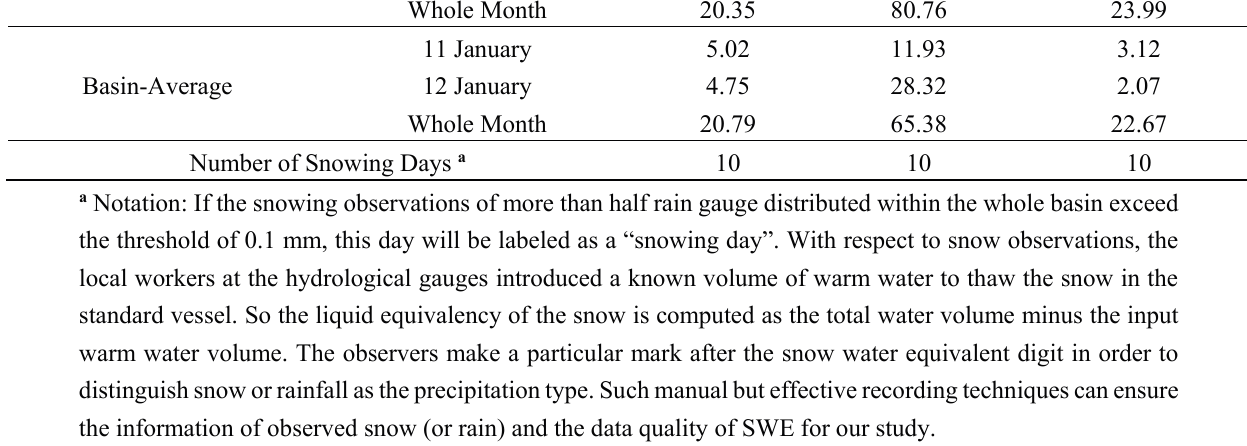
Table 4. Cumulative snowmelt of gauge observation, RTV7-R1, and RTV7-R2 for two largest snowfall events ( i.e. , 11 January and 12 January) and the whole month in January 2008 at the 32 selected gridboxes and basin-average in Jinghe river basin, respectively a . Cumulative Snowmelt (mm) Item Evaluating Data Gauge RTV7-R1 RTV7-R2 11 January